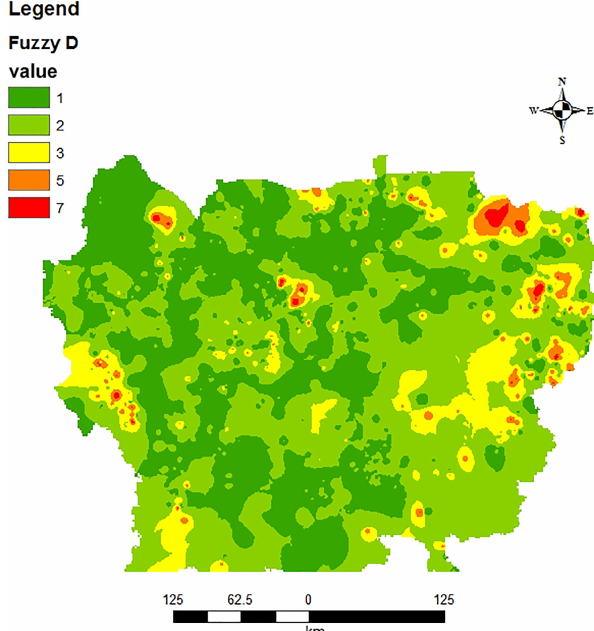
Figure 9. Fuzzy concept groundwater depth distribution